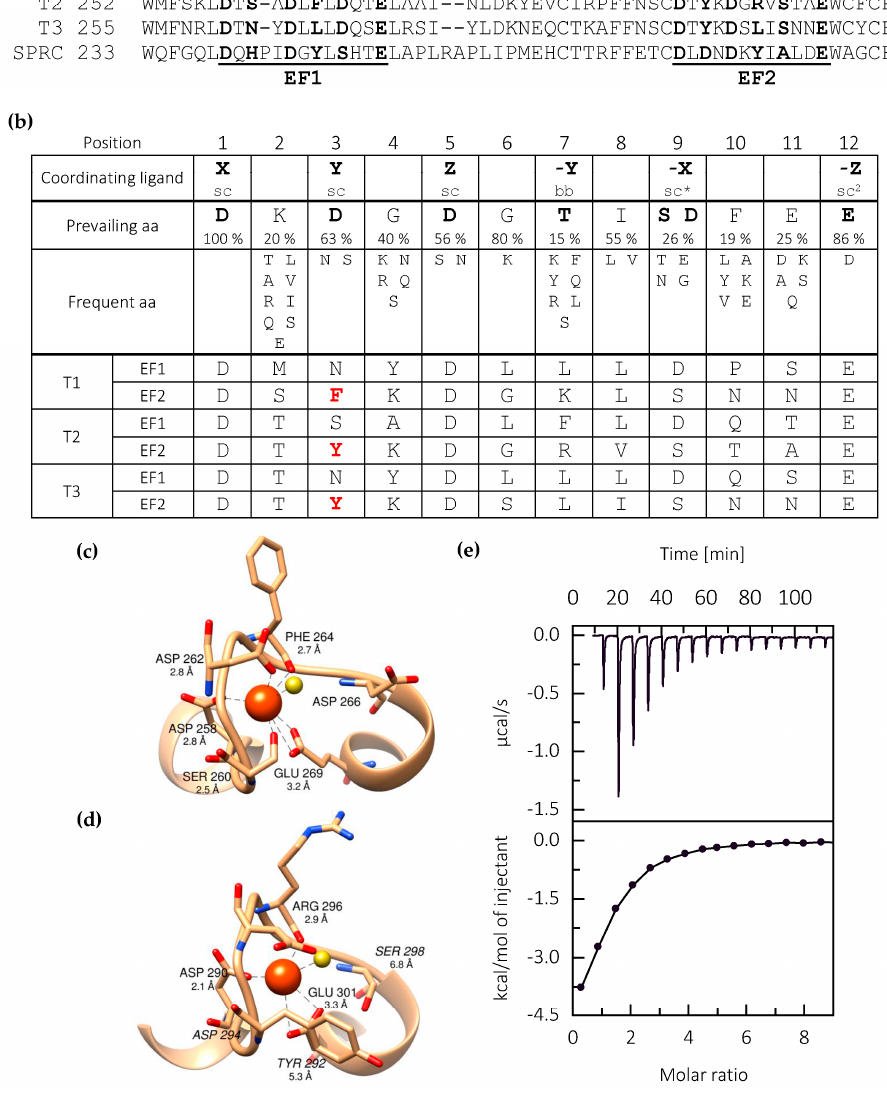
Figure 2. Calcium-binding EF-hand motifs in testicans. ( a ) Amino acid sequence alignment of both EF-hand motifs of the three testicans paralogues (T1, T2 and T3) and of the representative member of the SPARC protein family BM-40 (SPRC). Residues at sites critical for Ca 2+ coordination are shown in bold. ( b ) Amino acid preferences of the EF-hand loop. The most common residues forming the Ca 2+ coordination sphere and their loop positions are shown in bold. Coordination occurs either via side chain atoms (sc) or through the backbone atoms (bb). The asterisk marks the site where a water molecule serves as a bridge between the side chain and calcium ion. Sc2 indicates bidentate ligand. For all three testicans, residues in both EF1 and EF2 motif are listed; those significantly diverging from the EF-hand consensus sequence are shown in red. ( c , d ) Model of the EF1 ( c ) and EF2 ( d ) of testican-2. Residues forming the proposed coordination sphere are shown as sticks. Distance measurements between Ca 2+ and potential coordinating atoms are represented by dashed lines. Calcium atom and water molecule are represented as orange and yellow spheres, respectively. ( e ) Titration (ITC) of C-terminally truncated testican-2 (T2 Δ C) with calcium. The upper panel represents the raw heat of binding as a function of time, and the lower panel shows integrated heat change after subtracting heat of dilution at different molar ratios. Results indicate a stoichiometry of 1 Ca 2+ ion per 1 protein molecule.